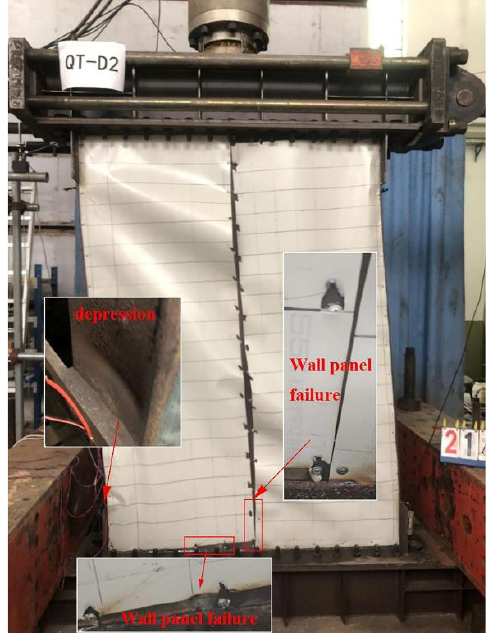
Figure 7. Failure image of QT − D2.